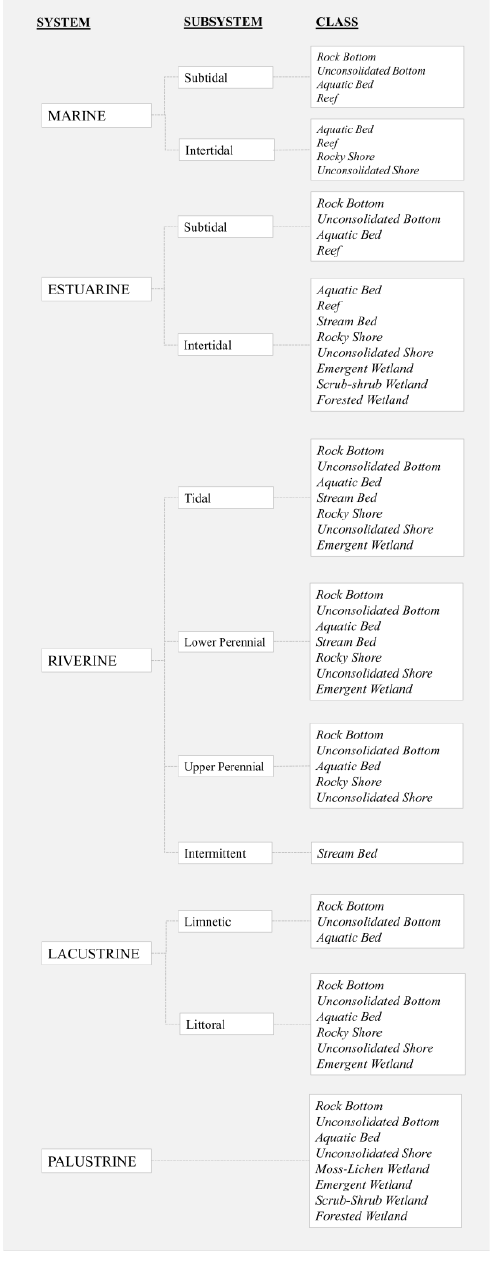
Figure 4. Cowardin Wetland Classification System. 249